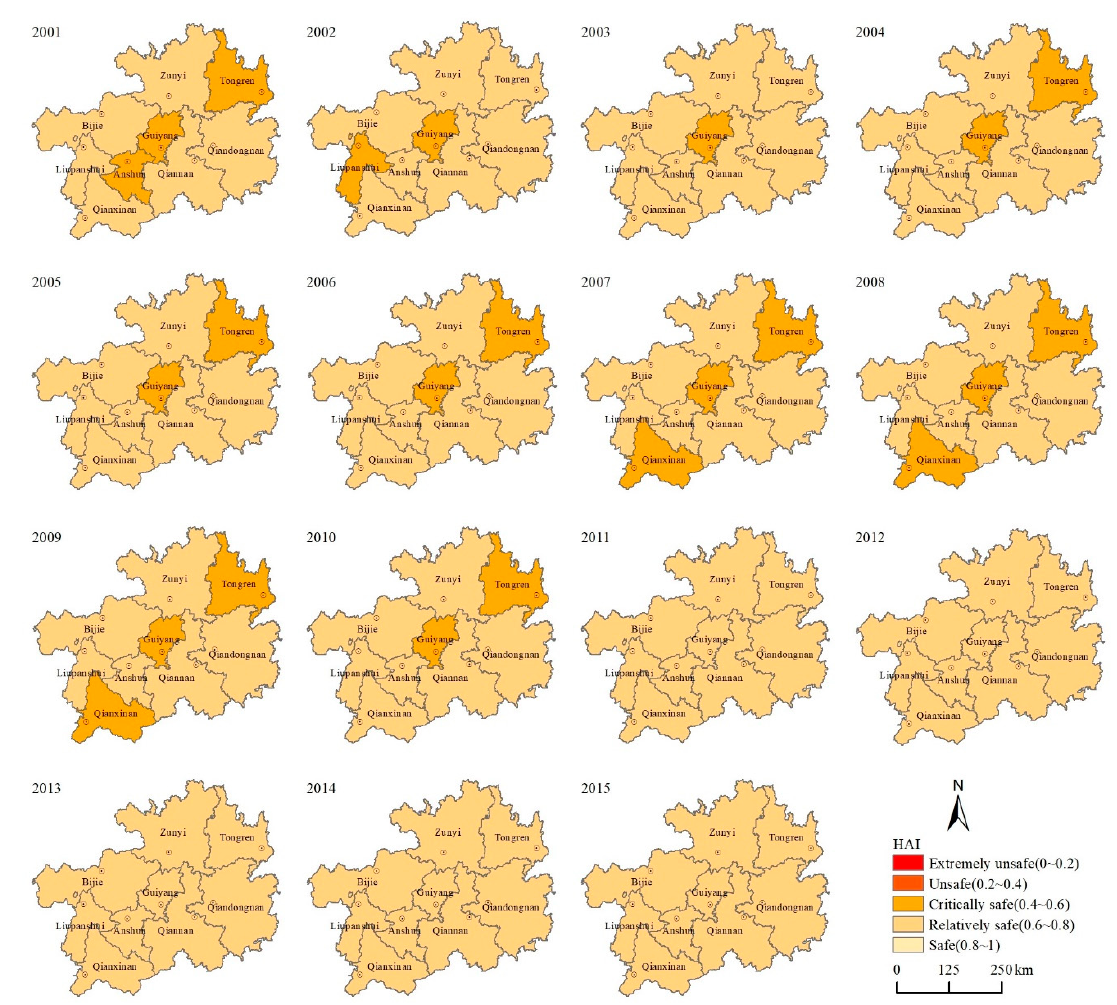
Figure 8. Spatiotemporal patterns of the HAII (Human Activity Intensity Index) in various cities and states in Guizhou Province in 2001–2015.